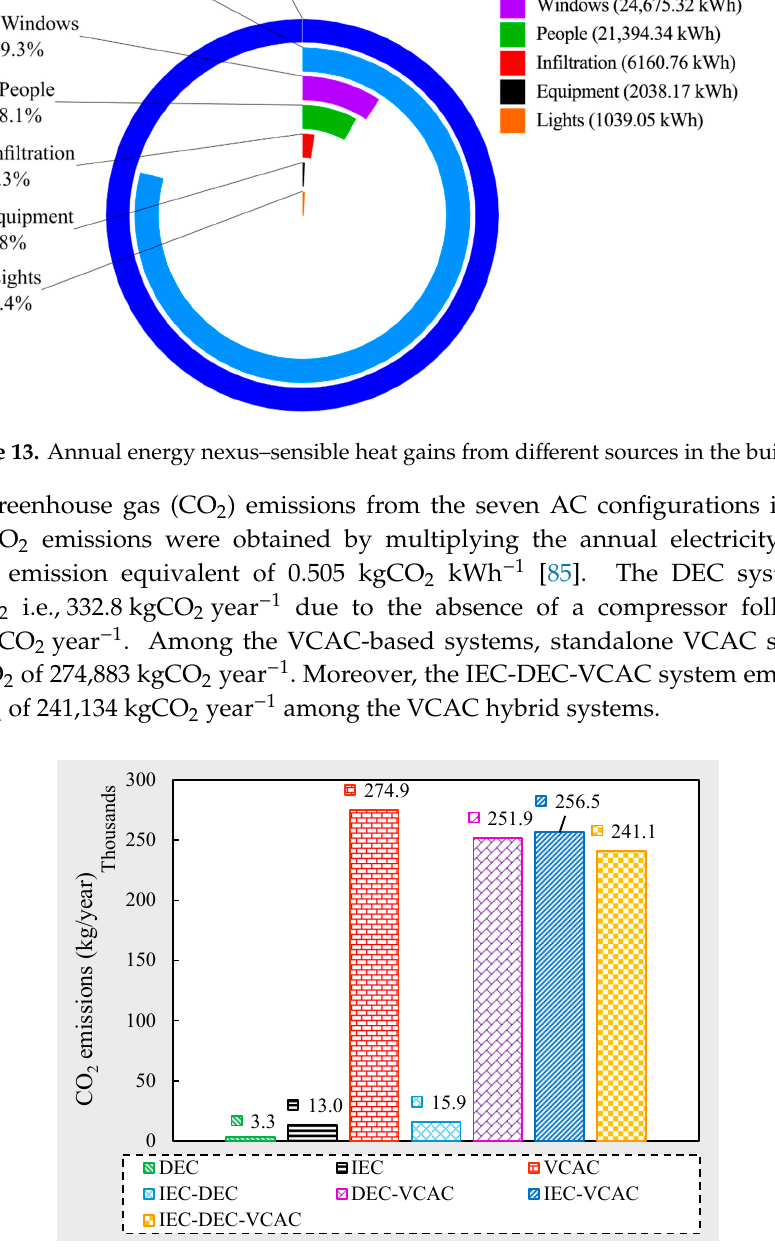
Figure 14. Annual CO 2 emissions of the proposed cooling systems in the